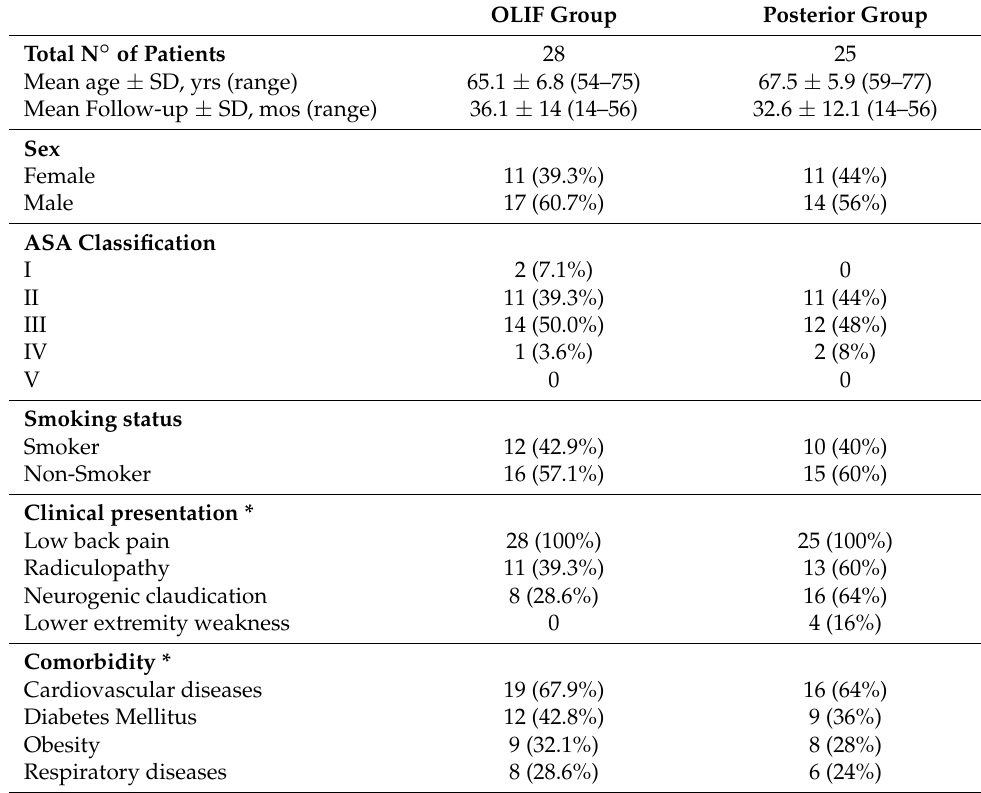
Table 1. Patient